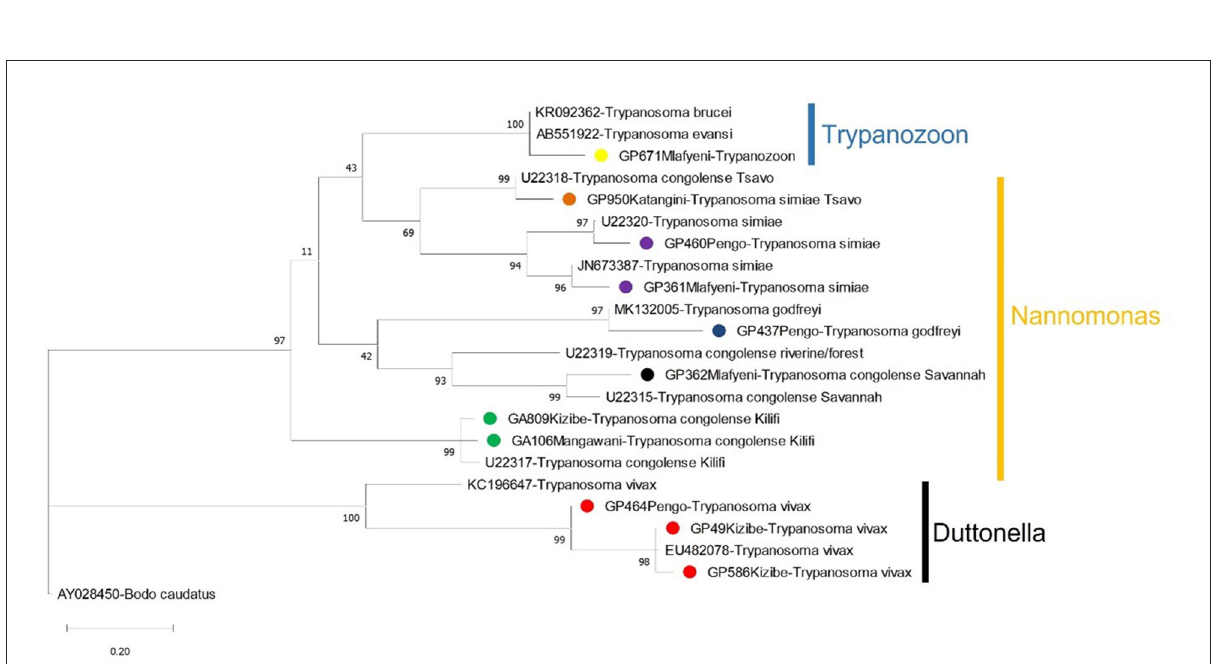
FIGURE4 A Maximum-Likelihood phylogenetic tree showing the species of trypanosomes detected in tsetse flies in Shimba Hills in Kenya (November 2018 to September 2019). Sequences from the study are bulleted using different colors to indicate trypanosome parasites. Other sequences shown on the tree were obtained from GenBank. Vertical bars are used to depict the subgenera of trypanosomes. Nodal support values based on 1000 bootstrap replicates are indicated next to each node. The branch length represents substitution per